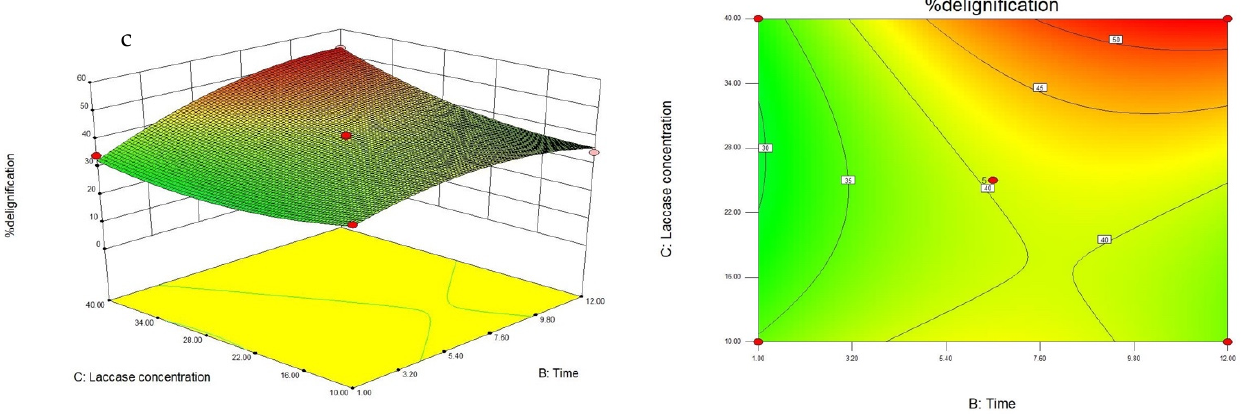
Figure 5. Contour and surface plots of the interaction between time and temperature ( a ), temperature and laccase concentration ( b ) and time and laccase concentration ( c ) on the percentage of delignification.